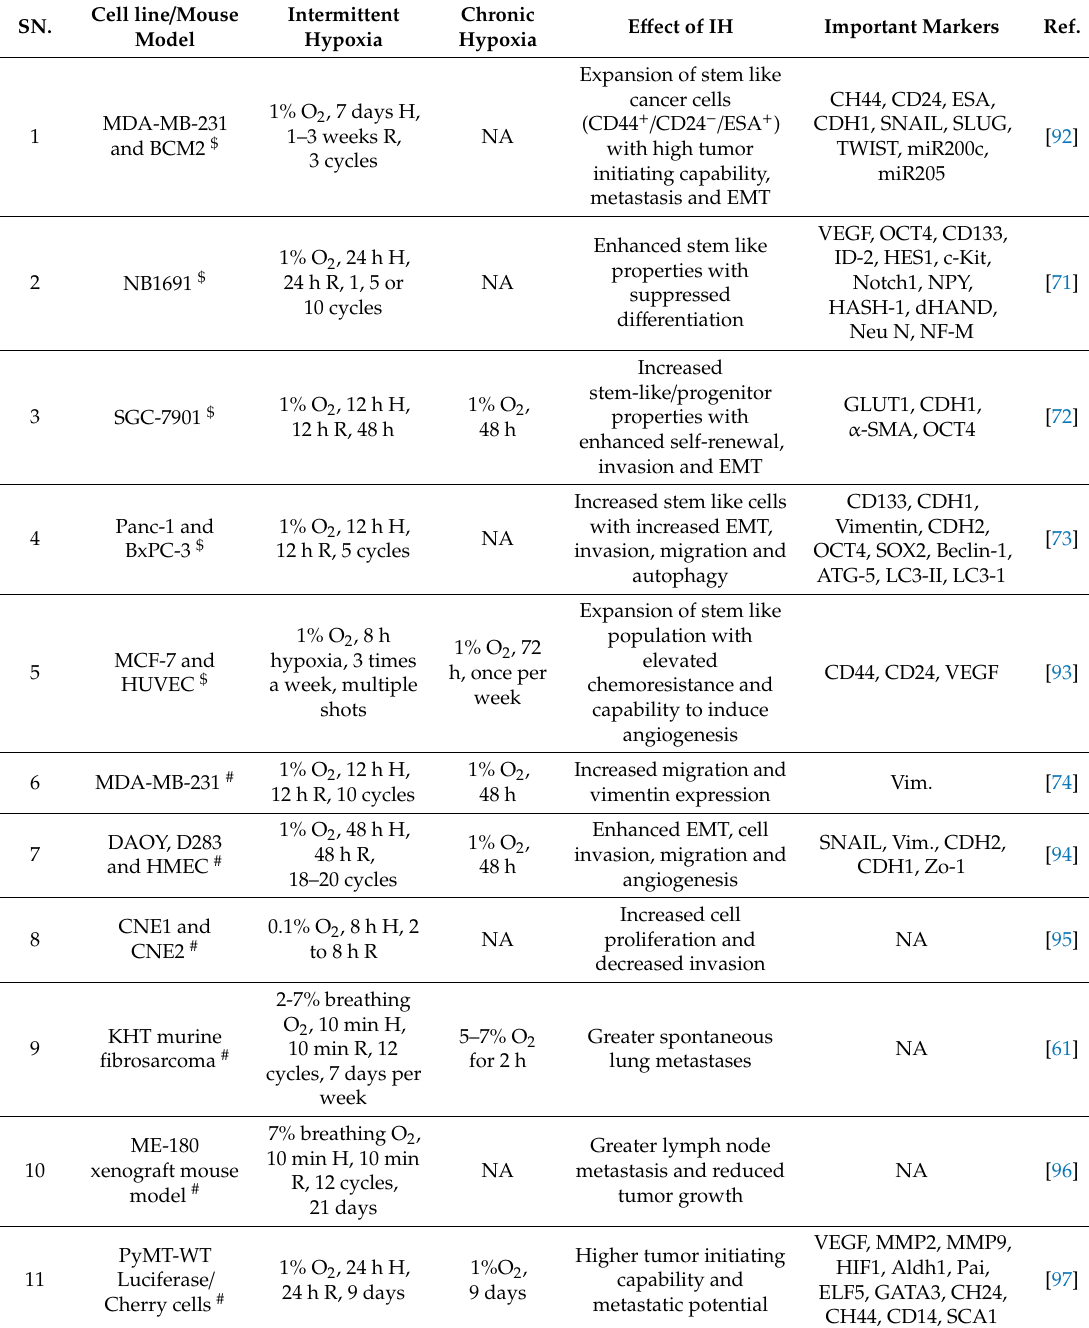
Table 4. E ff ect of IH on stemness, epithelial–mesenchymal transition (EMT) and metastasis.